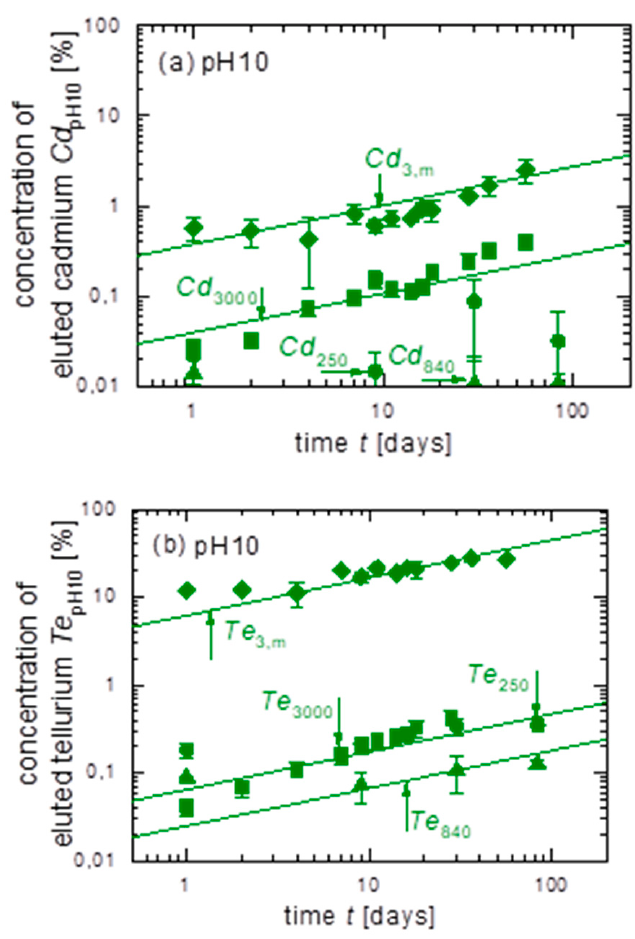
Figure 5. Elution of Cd pH10 and Te pH10 in solutions with pH10 out of CdTe powder and for milled module pieces. ( a ) The size dependent leaching of Cd pH10 changes when compared to the acidic elution in Figure 1. Here it holds Cd 3,m > Cd 3000 > Cd 840 ≈ Cd 250 . The Cd 3,m -value for the milled modules pieces is highest. ( b ) Leaching of Te pH10 is also size dependent. However, for the powders, there is not much difference for the different particle sizes. The lines, again, represent a fit of Equation (5) with the time dependence t 0 .